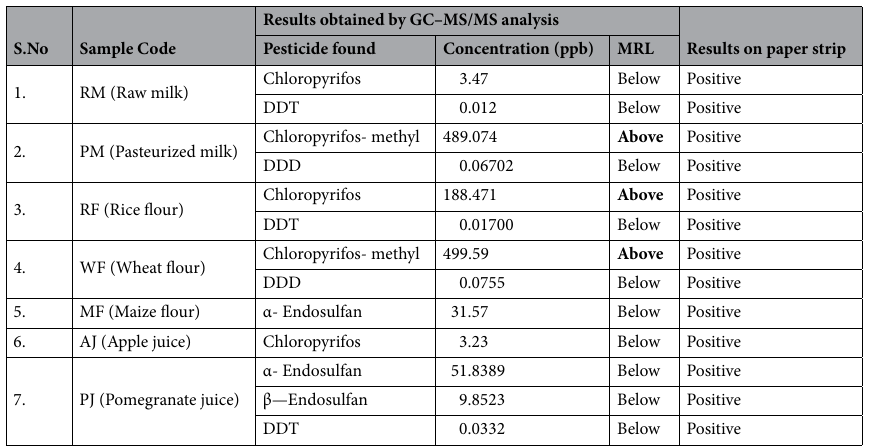
Table 3. Comparative analysis of food samples in Paper strip sensor and